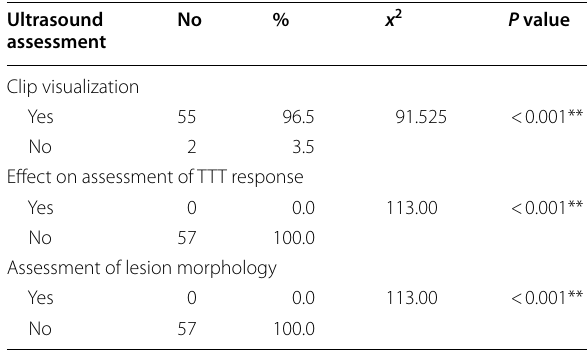
Table 2 Ultrasound clip assessment after treatment